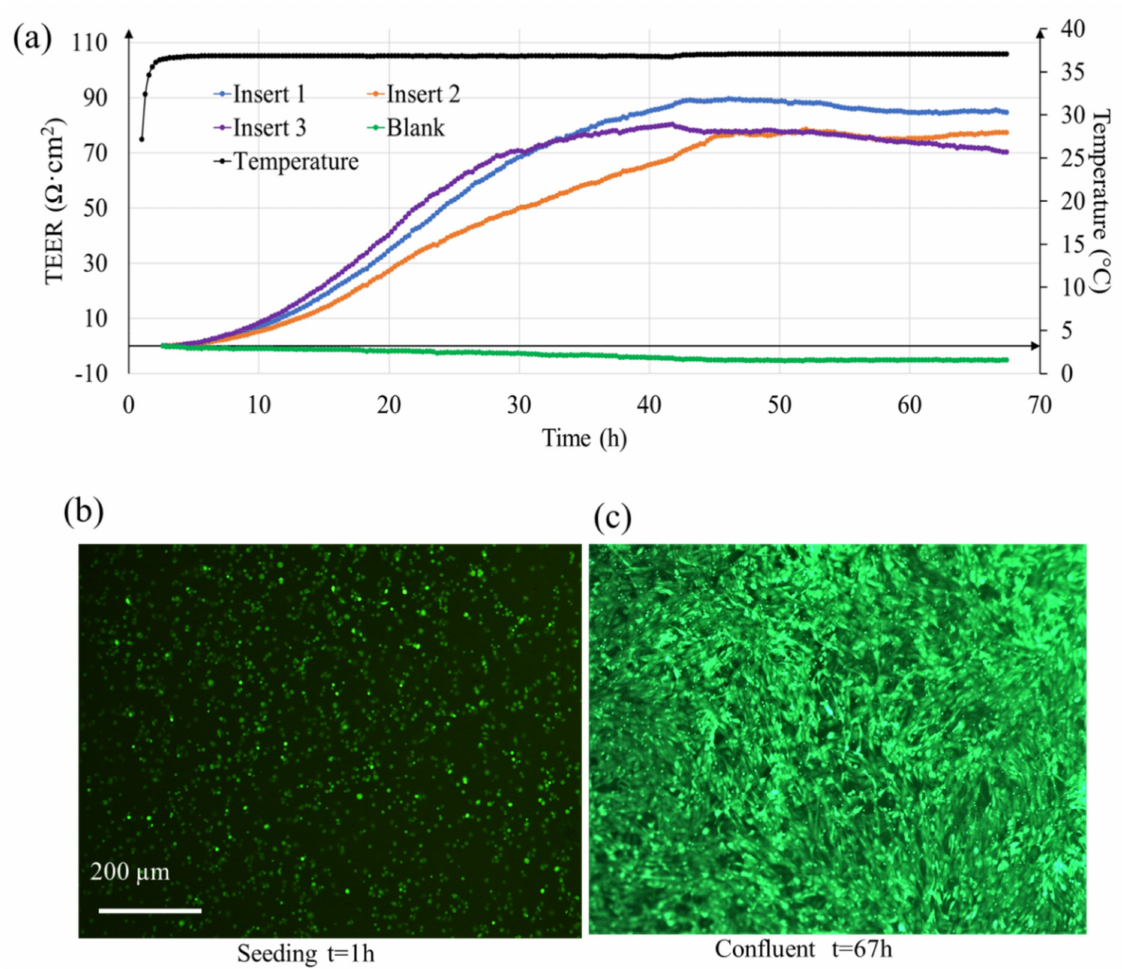
Figure 4. ( a ) Real-time TEER measurement of ARPE-19 cells (processed data) in transwell with in-situ temperature sensing. Inserts 1–3 contained cells and blank contained only cell culture medium. Fluorescence image of ARPE-19 cells ( b ) 1 h after seeding ( c ) 67 h when fully confluent.